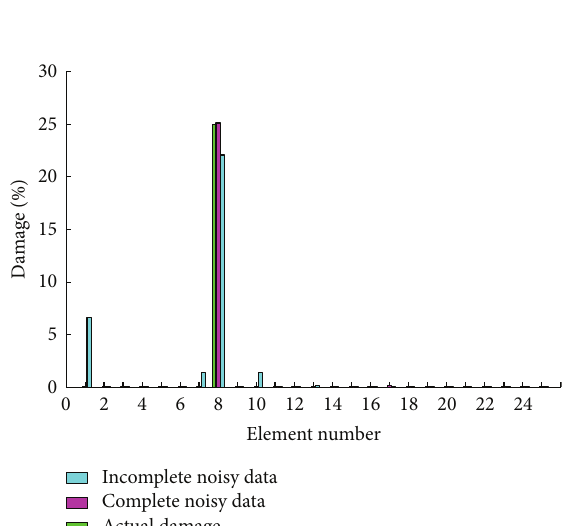
Figure 7: The convergence history of the Bowstring truss for the CSS and PSOPC algorithms.